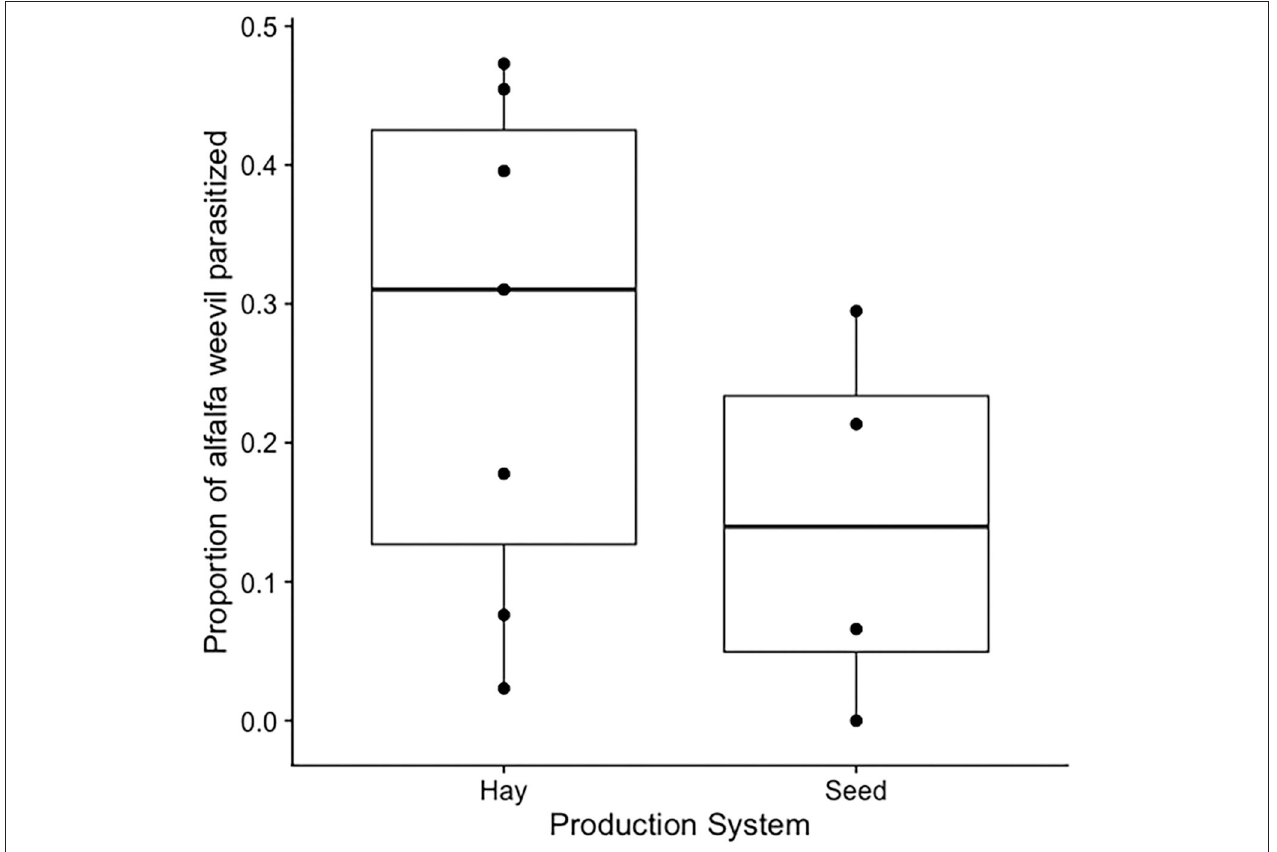
FIGURE 4 | Proportion of late-instar alfalfa weevil larvae parasitized by wasp Bathyplectes curculionis in June